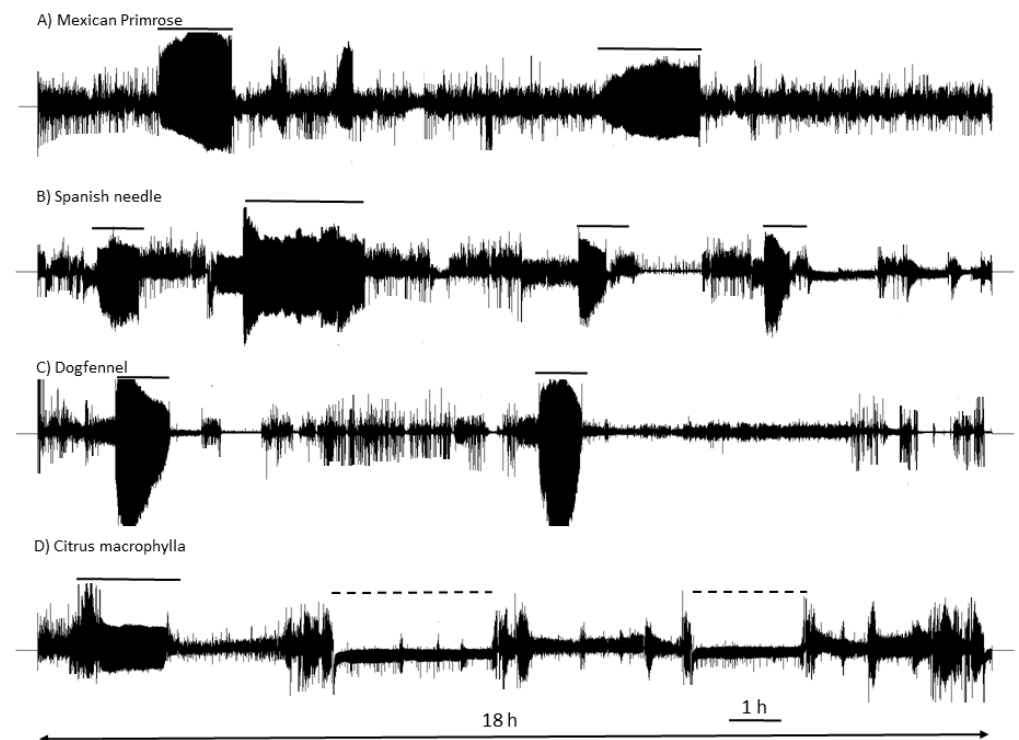
Figure 1. Example electrical penetration graph recordings illustrating feeding activities of Diaphorina citri adults on the weed species during 18 h recordings: ( A ) Mexican primrose, ( B ) Spanish needle, ( C ) Dogfennel, and a preferred host ( D ) Citrus macrophylla . Horizontal black lines indicate xylem feeding (G) and dashed black lines indicate phloem feeding (E2). Black horizontal scale bar shows 1